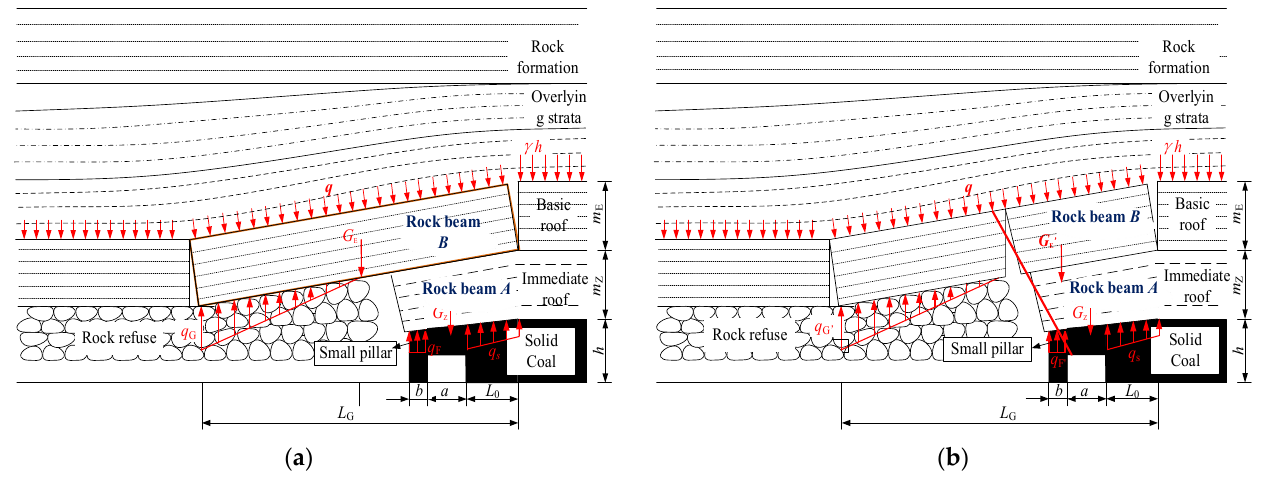
Figure 3. Deformation and failure of surrounding rock of roadway; ( a ) Before hydraulic fracturing roof cutting; ( b ) After hydraulic fracturing roof cutting.